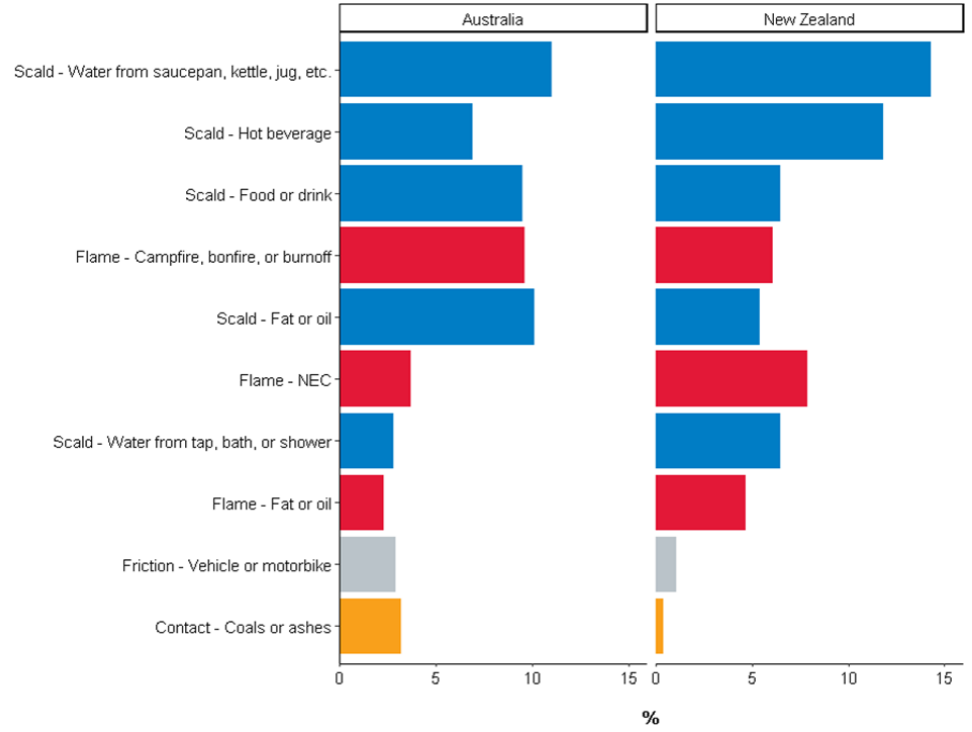
Figure 2. Top 10 injury subcauses during peak injury time by country. NEC = not elsewhere classi-